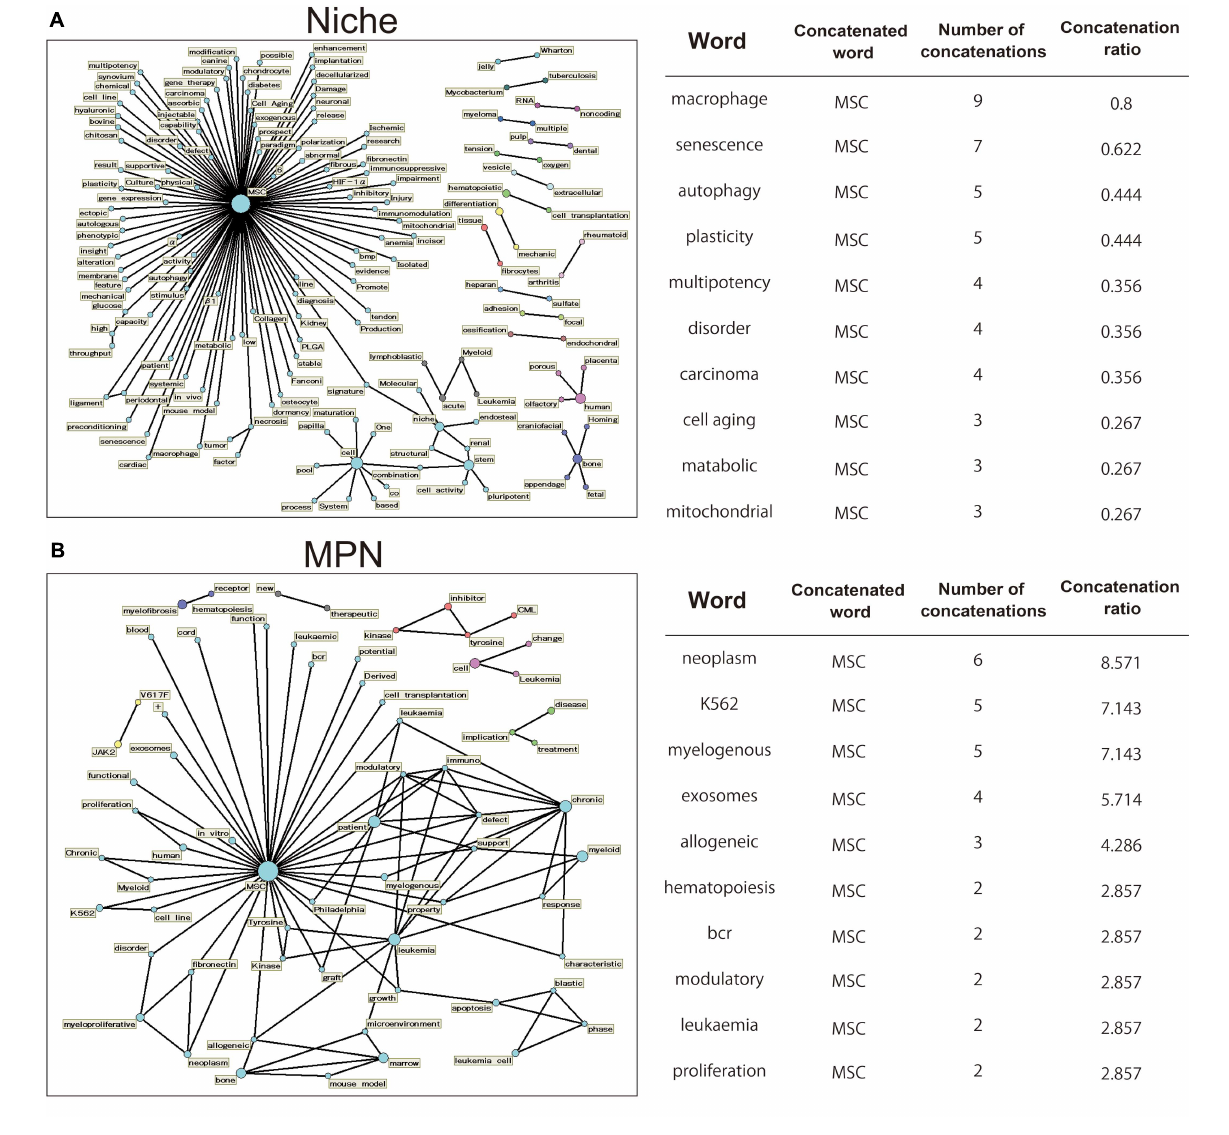
FIGURE 1 | Analysis of word highly related to MSCs using the text mining method. Using PubMed, we extracted articles referring to MSCs in their titles using a collection of MeSH word that describe MSCs. We focused on the word related to “niche” or “MPN,” and created a term network using Text Mining Studio 6.3 (NTT DATA Mathematical Systems Inc.) with the following analysis conditions: “niche” and “MPN,” frequency > 2, confidence level 30%. (A,B) The obtained data are shown as a network diagram demonstrating the relations between words. Word-relationship diagram related to the word “niche” [ (A) left] and “MPN” [ (B) left]. Representative 10 words are shown on the right table [ (A) right and (B) right]. “Concatenated word” is those concatenated with the representative word. “Number of concatenations” indicates the number of occurrences of concatenated words. “Concatenation ratio” indicates the ratio of concatenated articles in the extracted